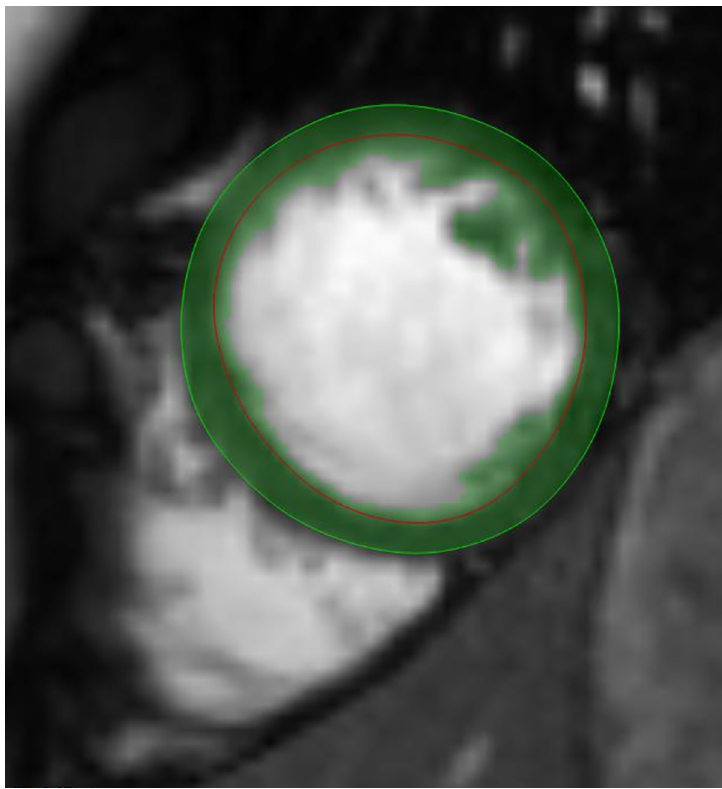
Fig 1. The threshold-based (TB) method. The program identifies each voxel within the left ventricular epicardial contour (green line) as either blood or myocardium according to the chosen threshold. Inside the endocardial contour (red line) the green area represents the trabeculated and papillary muscle mass (TPMi).